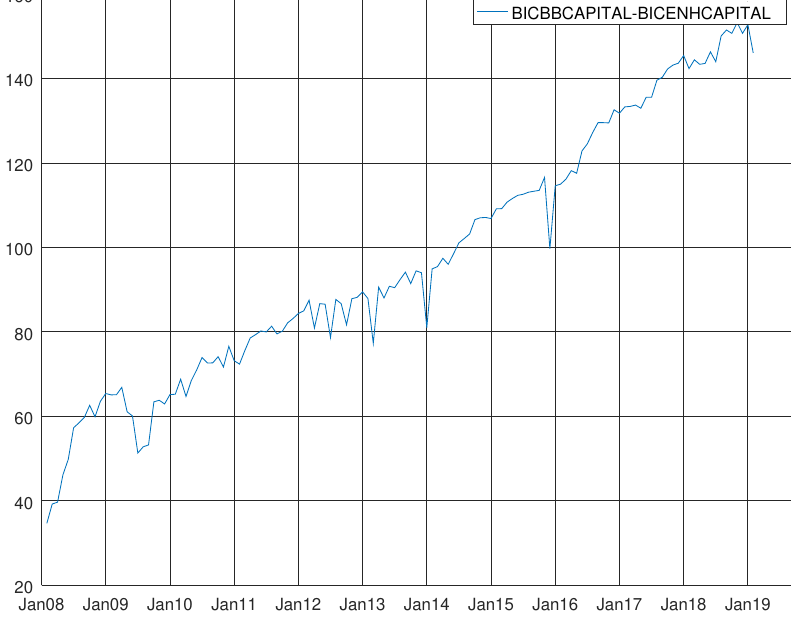
Figure 16. Graph showing the difference between the Bayesian information criterion of the barebone model and the enhanced model for capital goods.